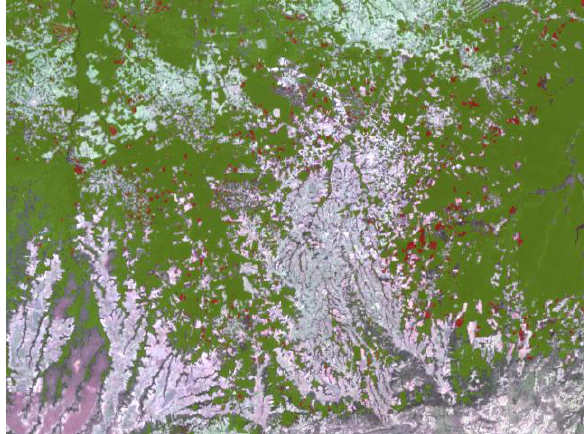
Figure 5. Deforestation assessment in Amazon (forest: green; deforestation: red) from MODIS